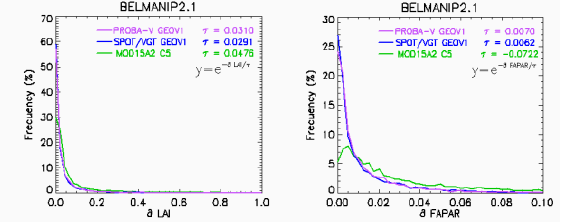
Figure 7: Histograms of the delta function (smoothness) for LAI, and FAPAR products for BELMANIP2.1 sites during the November2013-May2014 period. The curves are adjusted to an exponential function and the exponential decay constant is presented in the figure.